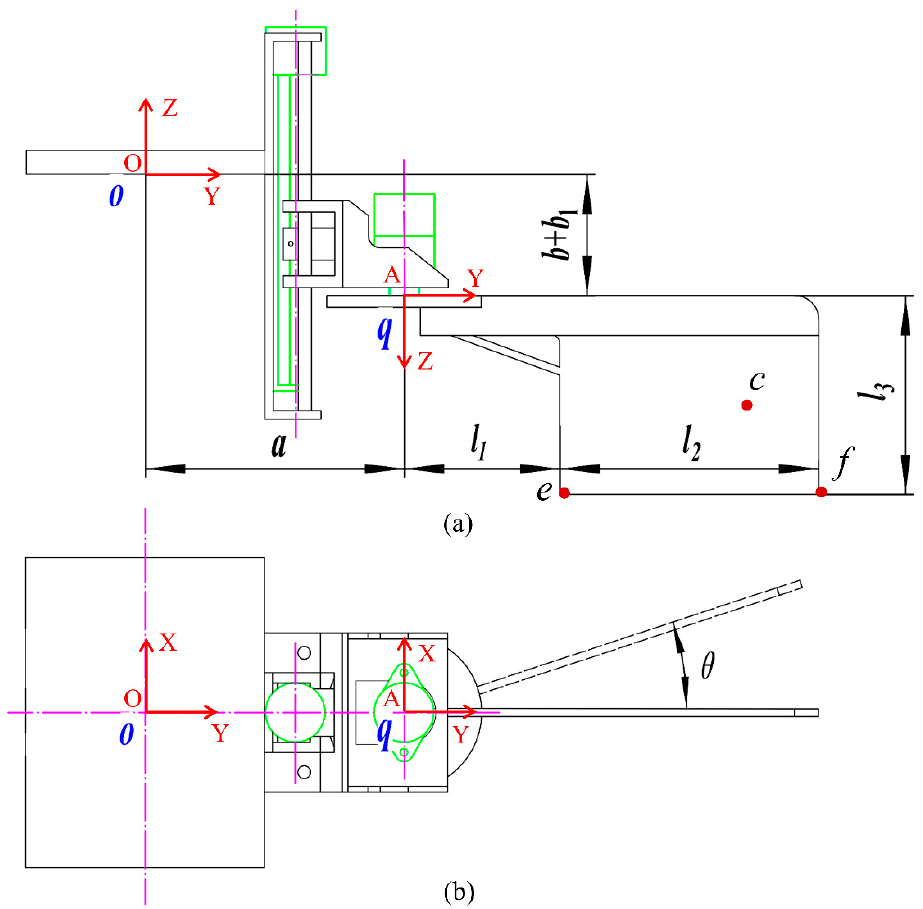
Figure 3. Front and top view of the stroke mechanism: ( a ) the front view; ( b ) the top view. In the initial state (i.e., after the robot is assembled and before it runs), for the coordinate system O and A, the X and Y positive axis horizontally extend on the paper, and horizontally extend to the right, respectively. The Z positive axis vertically extends upward and downward for coordinate system O and coordinate system A, respectively. b 1 is the displacement of the paddle in the vertical direction.